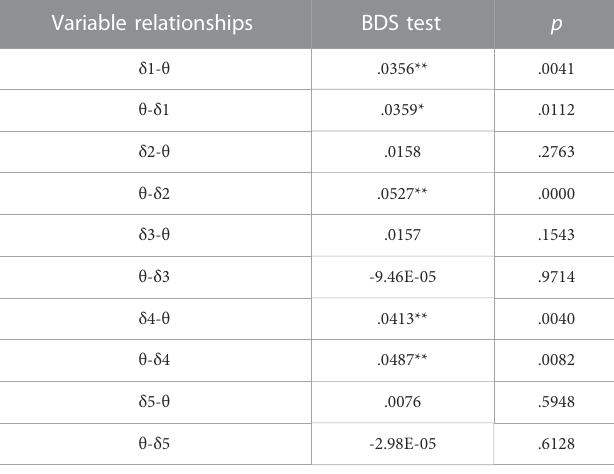
TABLE 3 Test results of non-linear change trend. Variable